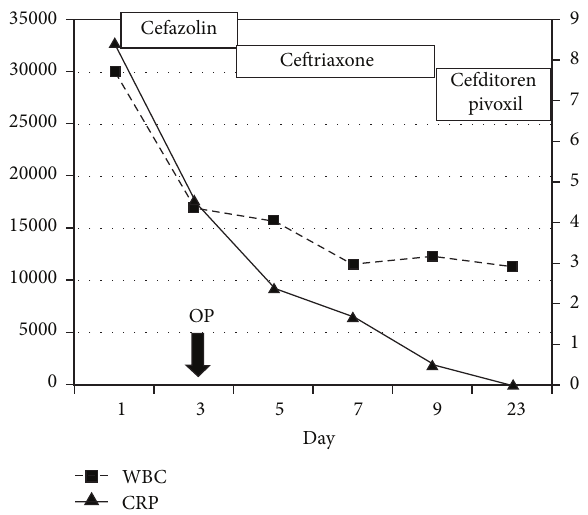
Figure 4: Sequential changes of a CRP and a WBC counts. A CRP was still higher on day 3 and the arthroscopic surgery was performed. After the operation, the CRP level gradually decreased and normalized. OP: operation, CRP: C-reacting protein, and WBC: white blood